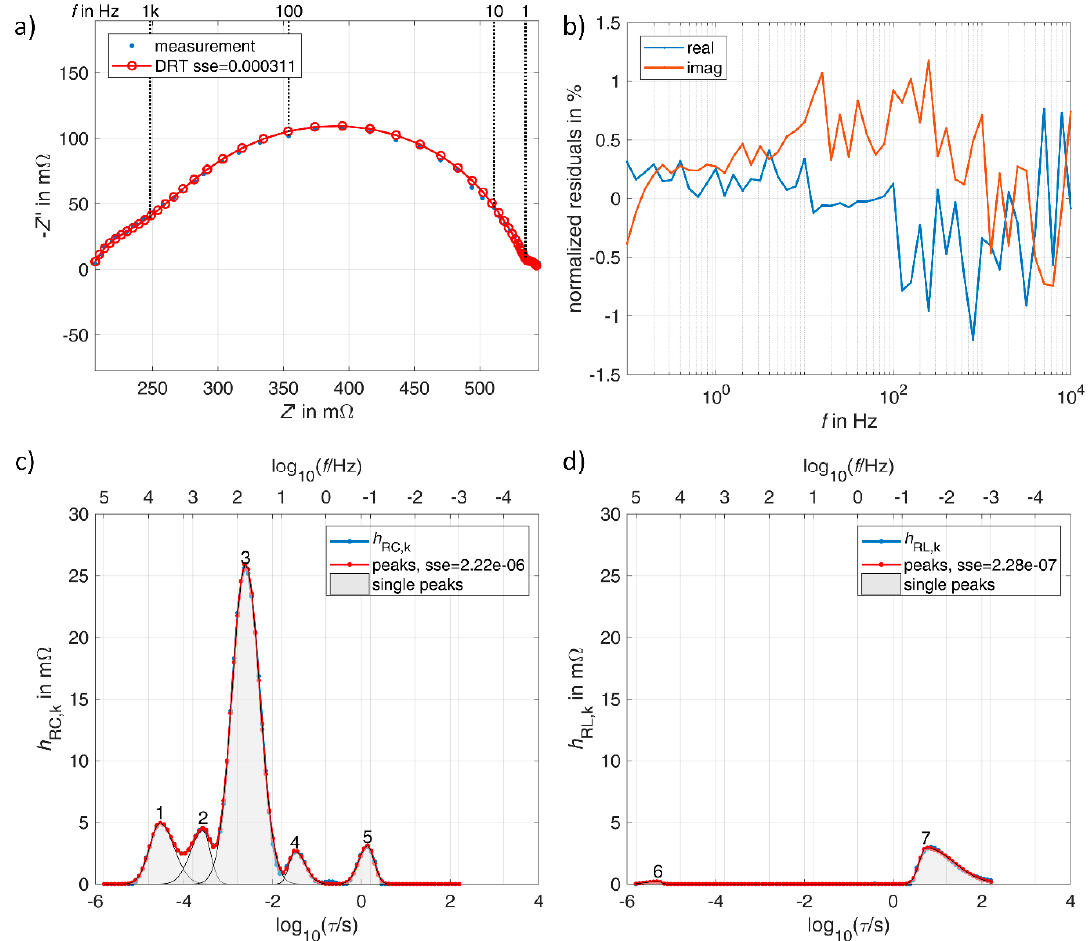
Figure 5. Generalized DRT analysis of a vanadium redox-flow battery (Micro Flow Cell, Separator Nafion, Electrodes SGL GFA6) with the sum of squared errors ( sse ) of each plot. ( a ) Measured and calculated impedance spectrum; ( b ) Normalized residuals of real and imaginary part of the impedance spectra of subplot ( a ); ( c ) Identified resistive-capacitive distribution of relaxation times function; ( d ) Identified resistive-inductive distribution of relaxation times function.